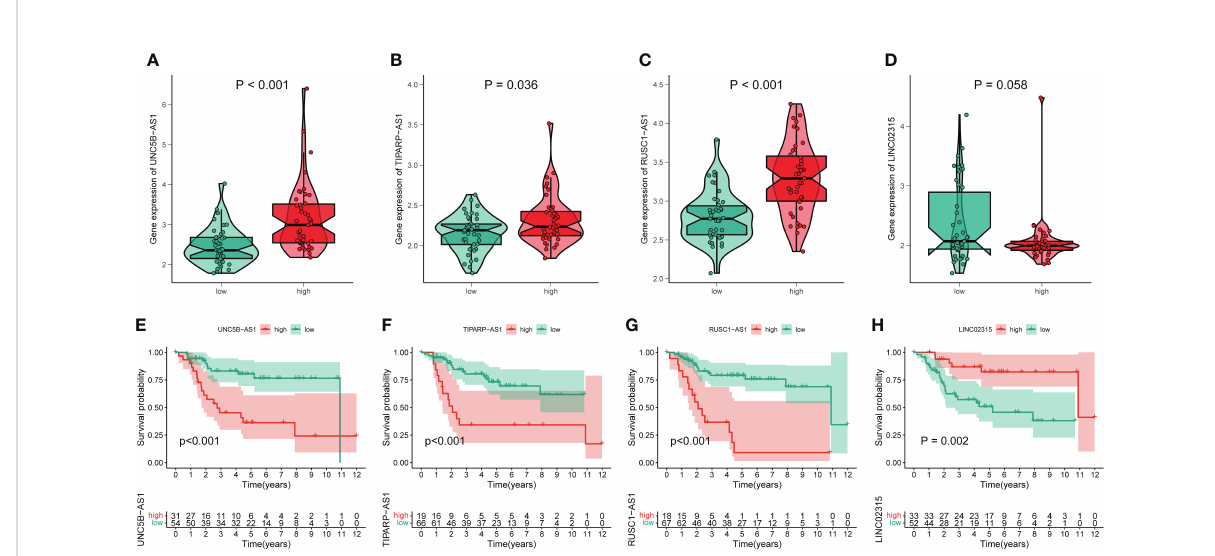
FIGURE 4 The association of these signature lncRNAs with OS. (A – D) The expression level of each signature lncRNAs in the low- and high-risk groups. Green and red represent the low-risk group and high-risk group, respectively. (E – H) The K-M survival curves for these four signature lncRNAs in